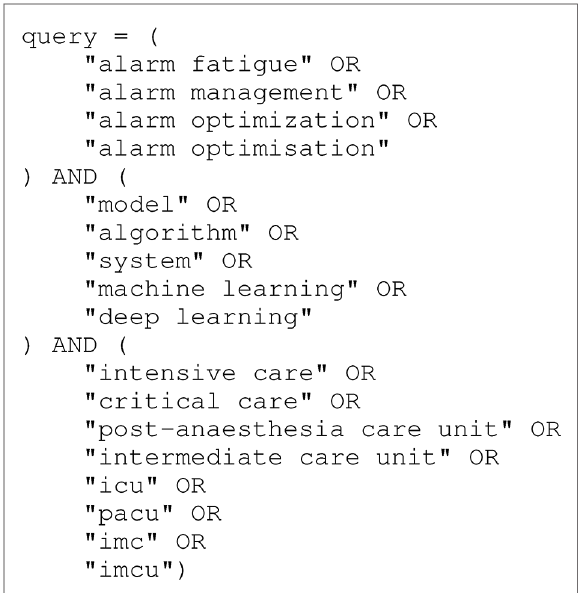
FIGURE 1 Database query used on all public databases. The fi rst part of the query sets the topic domain, the seconds part de fi nes the computer science aspects, and the third part de fi nes the medical aspects.